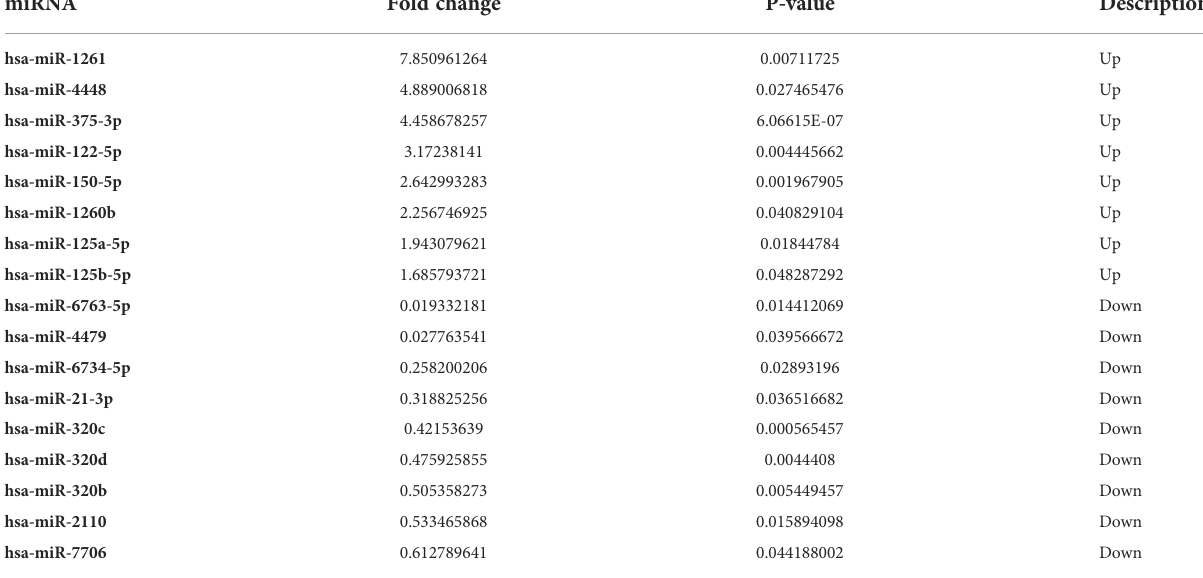
TABLE 3 Up-regulated and down-regulated miRNAs of EOC patients. miRNA